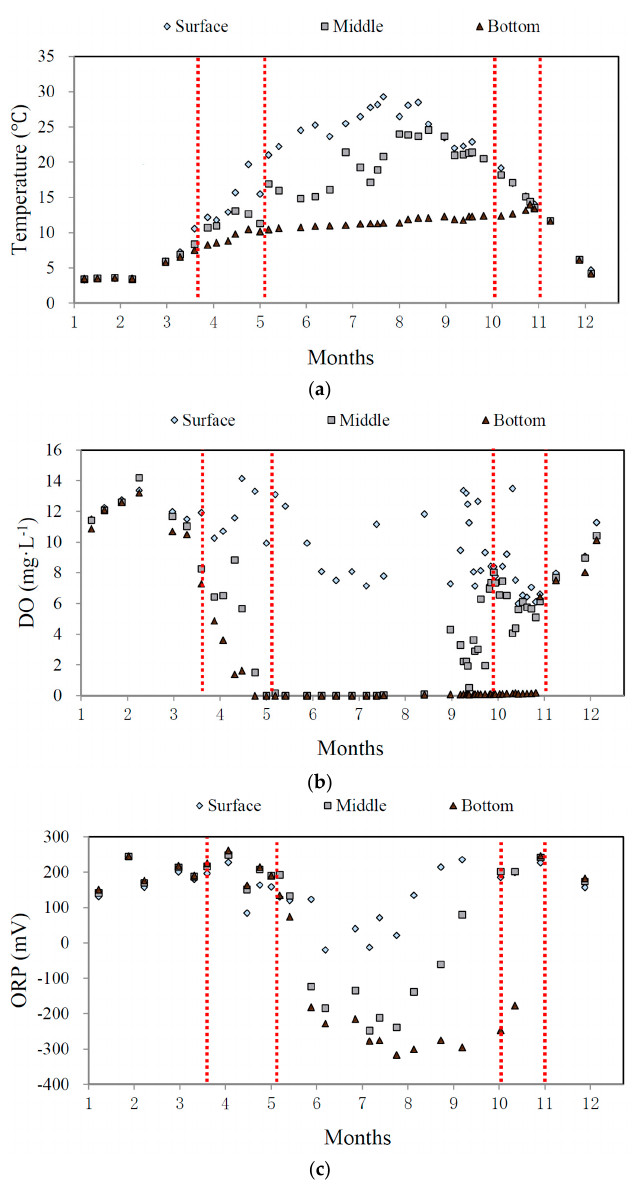
Figure 6. Variation of temperature ( a ); DO ( b ); and ORP ( c ) in different water layers in the Zhoucun Reservoir.